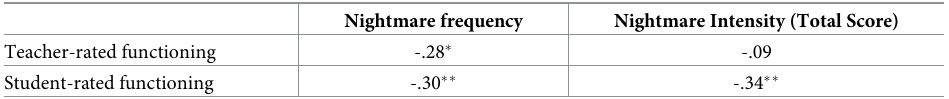
Table 4. Correlations of nightmare symptoms with functional